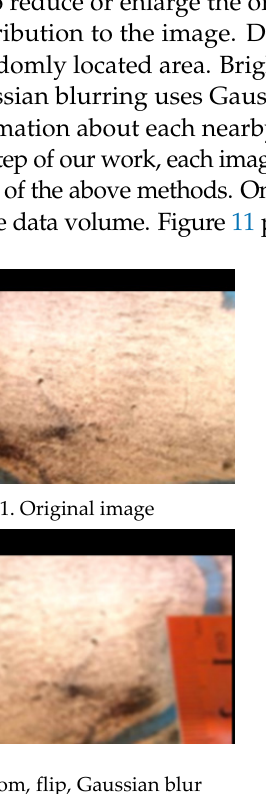
( b ) Figure 11. Image enhancement example of two images: ( a ) Random Image Enhancement Combi- nation 1; ( b ) Random Image Enhancement Combination 2